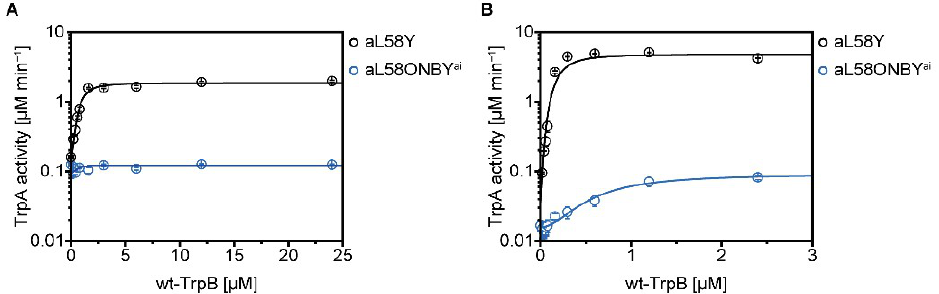
Figure 5. Activity titration experiments to show the stimulation of aL58ONBY ai and aL58Y by wild-type TrpB in the absence ( A ) and presence ( B ) of serine. Reaction conditions: 50 mM Tris·HCl pH 7.8, 100 mM NaCl, 5 µM GAP dehydrogenase, 250 µM IGP, (5 mM serine), 5 mM NAD + , 20 mM Na 2 HAsO 4 , 40 µ M PLP, 0–24(0–2.5) µ M wild-type TrpB, and 1(0.2) µ M TrpA. All reactions were performed in